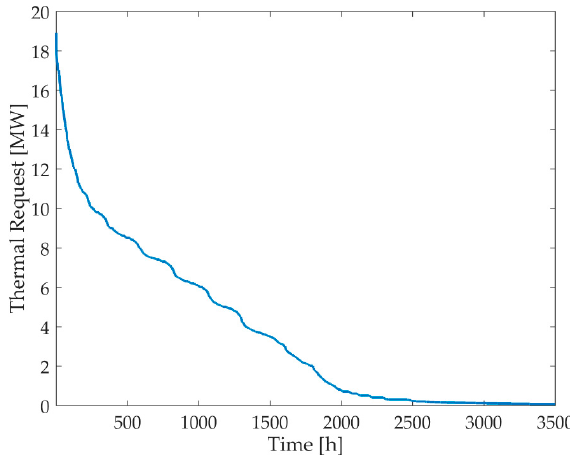
Figure 4. Total annual heating load duration curve for the PoliTo test case.